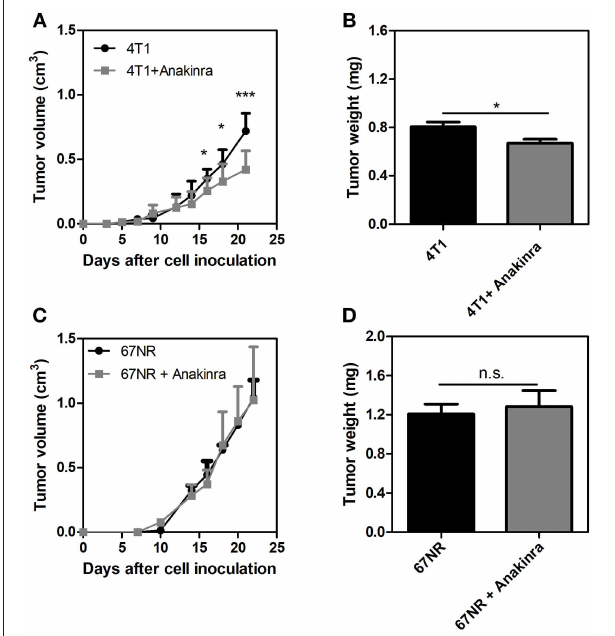
FIGURE 3 | The IL-1R antagonist anakinra reduces tumor growth in 4T1 tumor-bearing mice but not 67NR-bearing mice. Both 4T1 tumor-bearing mice (A) and 67NR tumor-bearing mice (C) received treatment with anakinra (10 mg/kg/day, s.c.) for 8 days between day 14 and day 21 after the tumor cell inoculation. The graphs show the tumor growth and the weight of the tumor (B,D) assessed 21 days after the inoculation. Values represent the mean ± SD. * P < 0.05 and *** P = 0.001; n.s., non-significant, unpaired two-tailed Student’s t